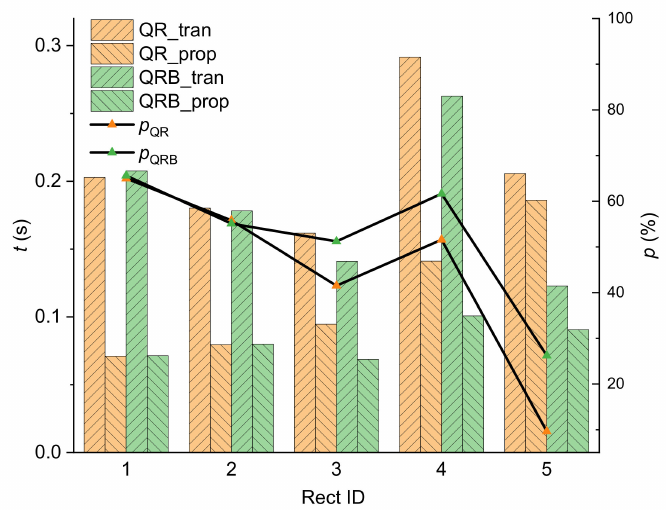
Figure 15. Comparisons between the proposed (prop) and traditional (tran) refinement methods. The two methods are adopted in the exact queries based on the QR-tree index (QR) and QRB-tree index (QRB). The right axis indicates the percentage of improvement ( p ) over the traditional method, (cid:0) (cid:1) t tran − t prop i.e., / t tran